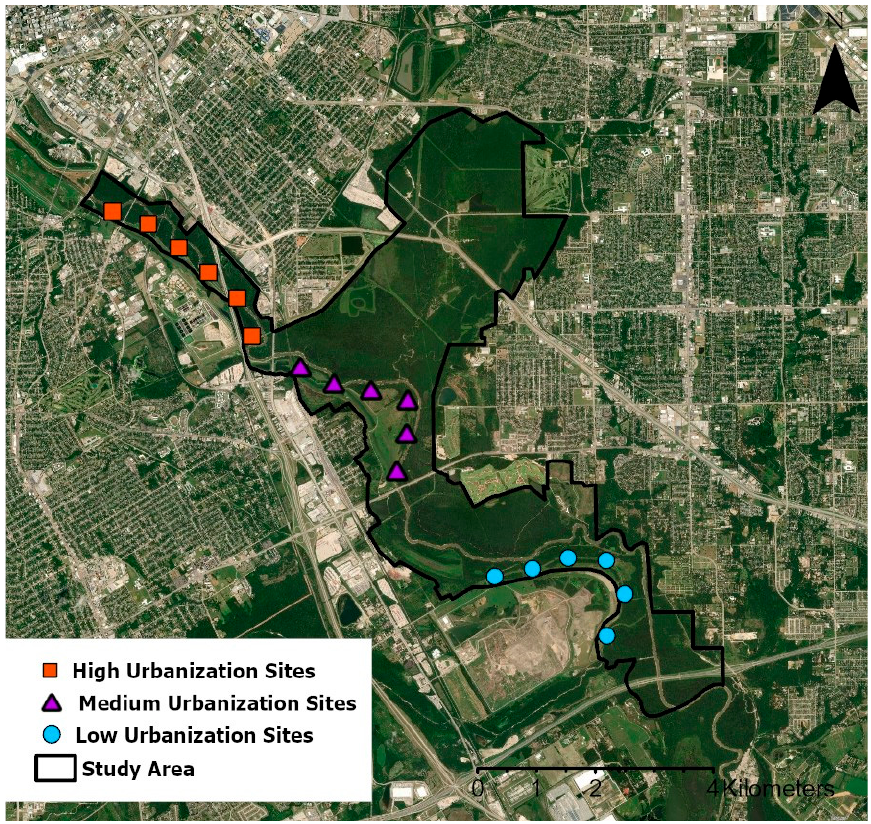
Figure 1. Study area within the Great Trinity Forest in Dallas, TX, USA (32.733043, − 96.733511). We assessed raptor activity/use and rates of predation along three transects that differed in urbanization level: high (red squares), medium (purple triangles), and low (blue circles). Individual shapes indicate raptor survey stations along transects. Land cover was assessed using ArcGIS Pro (version 2.2, ESRI, Redlands, CA).